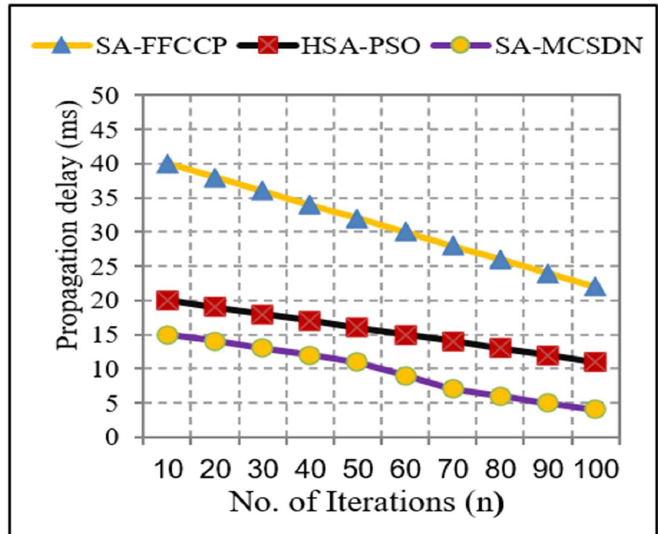
Figure 6. Comparison of propagation delay .